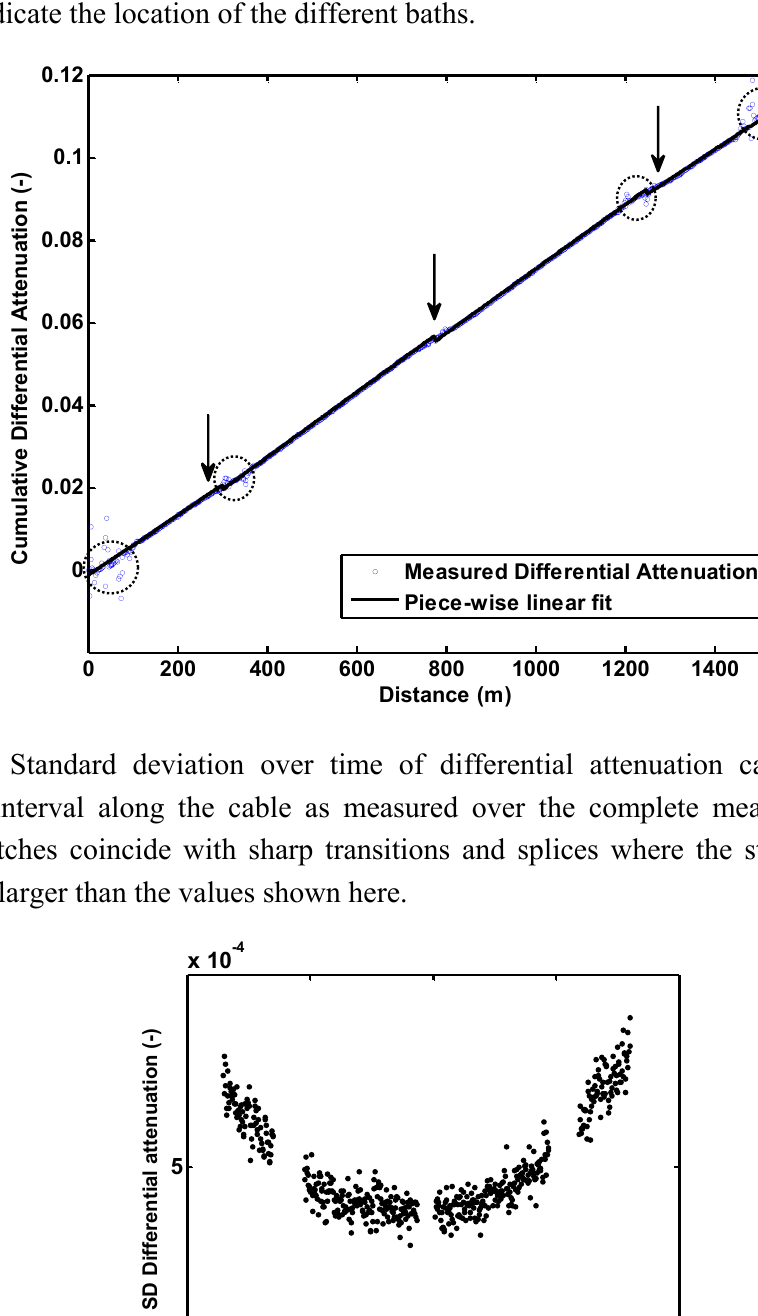
Figure 2. Measured Cumulative Differential Attenuation as calculated with Equation (4) and piece-wise linear fit. The arrows indicate the location of the splices and the dotted ellipses indicate the location of the different baths.